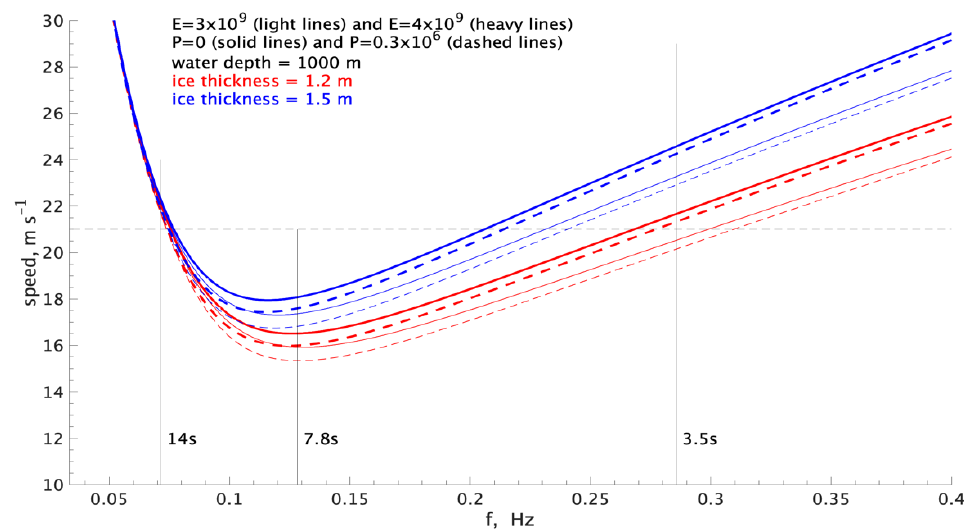
Figure 7. Dispersion curves for flexural-gravity waves for 1000-m depth and 1.2-m (red) and 1.5-m (blue) thick ice, for Young’s modulus values of 3 × 10 9 N m − 2 (light lines) and 4 × 10 9 N m − 2 (heavy lines), and compression stress of zero (solid) and 0.3 MPa (dashed). A 21 m s –1 wind speed is marked, along with the dominant wave periods, 3.5 and 14 s. The phase speed minimum for 1.2-m ice is 16–17 m s –1 and falls at ~7.8 s.